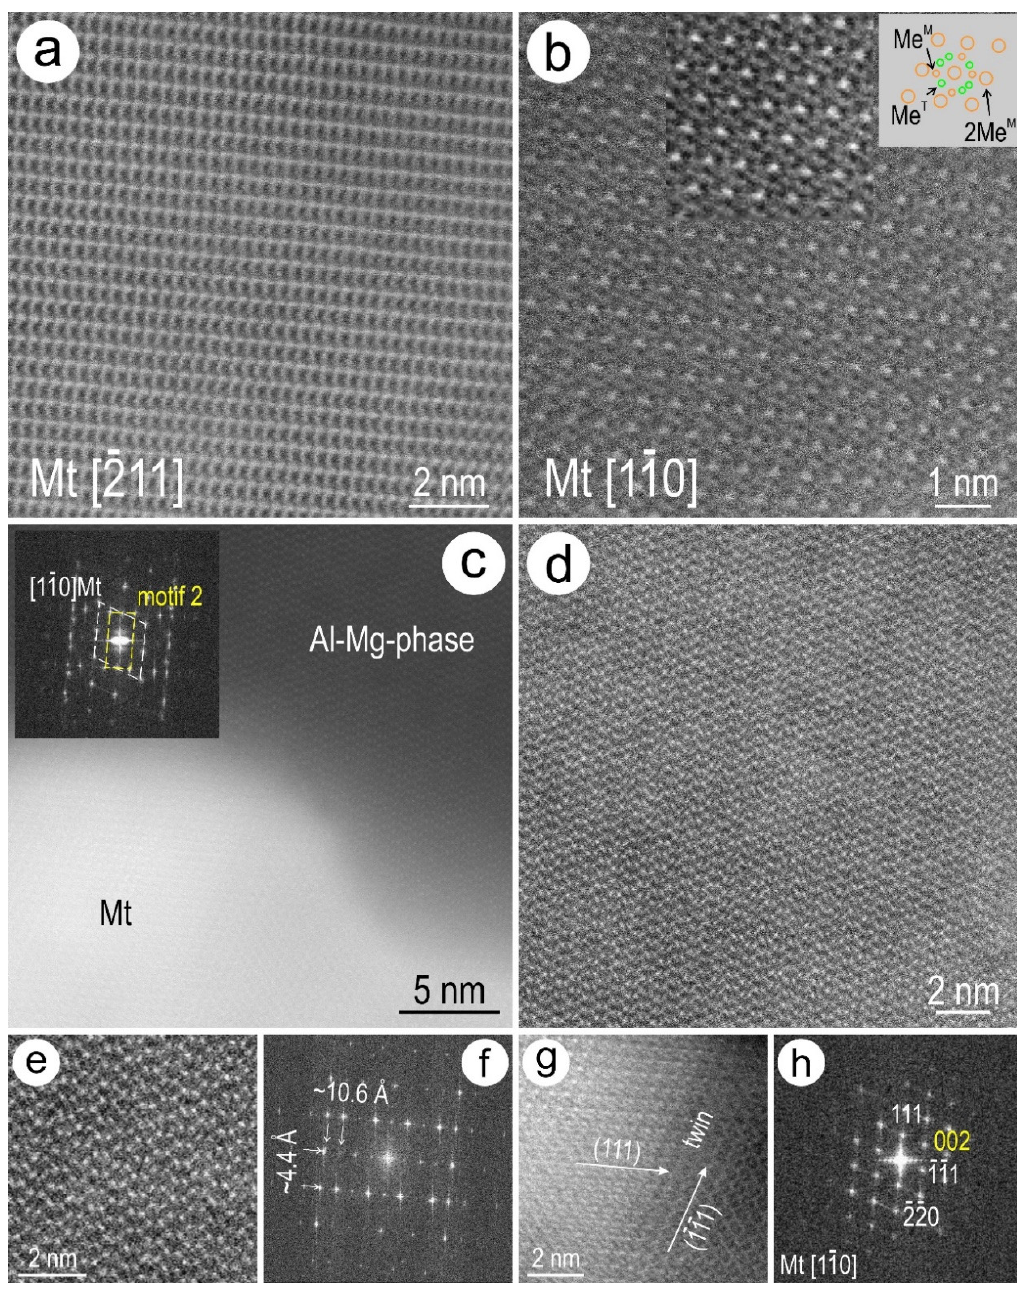
Figure 12. ( a , b ) High-resolution HAADF STEM images showing magnetite on zone axes, as marked. Interpretation of atomic arrangements based on a previous study [27]. The inset in ( b ) shows the typical ring of 10-smaller spots (single column metals in either octahedral (M) or tetrahedral (T) sites) surrounding each brighter or larger spot corresponding to double-column metal 2Me M with a beam parallel to the (110) direction. ( c ) Contact between magnetite and Al–Mg–phase with coherent orientation between the two species (FFT in inset). ( d ) High-resolution image of the Al-Mg-phase (spinel composition) showing the dumbbell atomic arrangement atypical for cubic spinels of high symmetry. ( e , f ) Details of the dumbbell structure and FFT obtained from ( d ). ( g , h ) Details of magnetite in ( c ) and corresponding FFT. This shows nanotwins in {111} directions. Forbidden reflections present on FFT in ( h ) are marked in yellow.